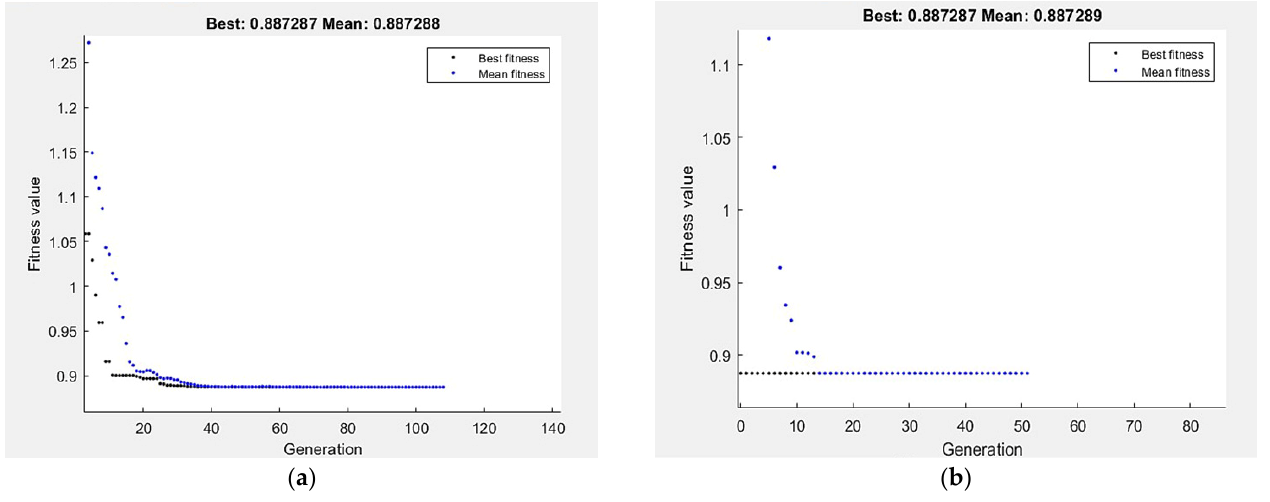
Figure 16. Optimum G R by GA ( a ), and hybrid RSM-GA ( b ).